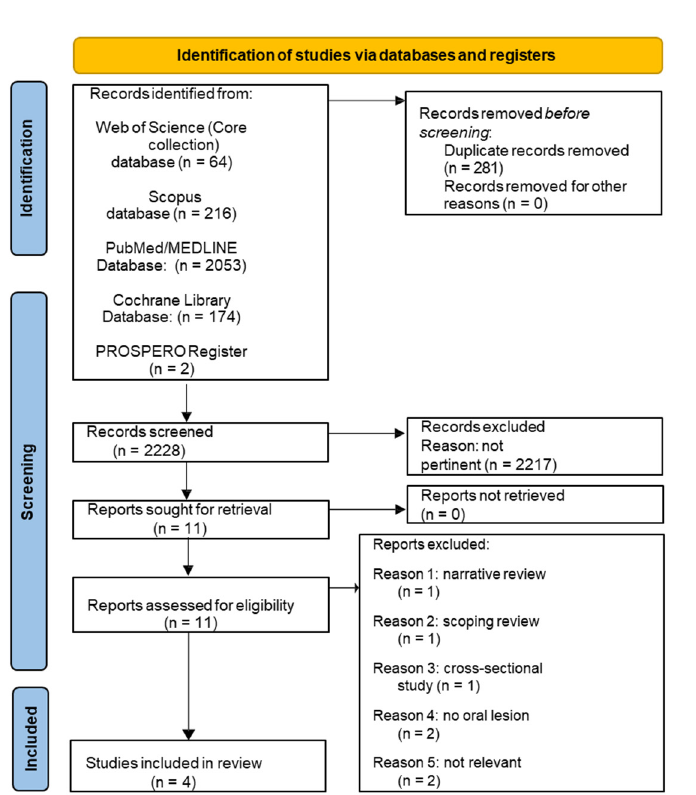
Figure 1. PRISMA 2020 flow diagram for new systematic reviews, which included searches of databases and registers only.